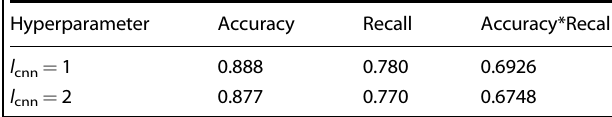
Table 2. Validation results for hidden size.